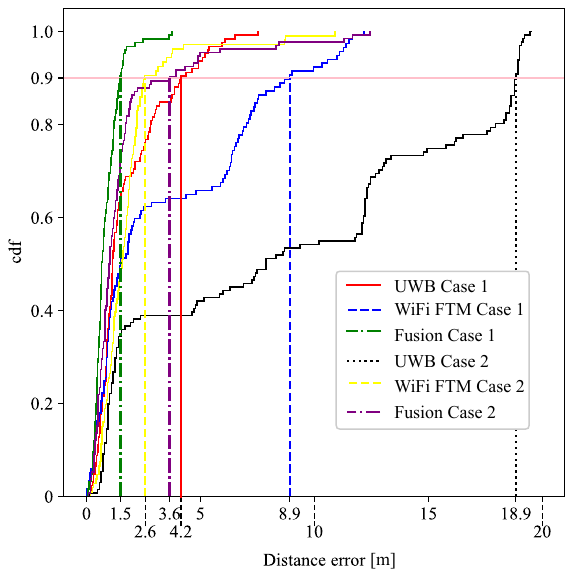
Figure 6. CDF of the horizontal error for Case 1 and 2.